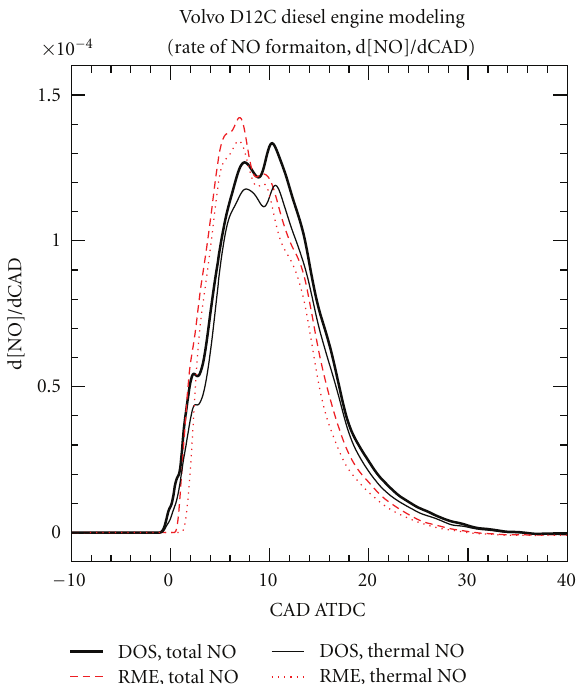
Figure 9: Averaged in-cylinder rates of NO formation for the Volvo D12C diesel engine fuelled by DOS (black solid line) and RME (red dashed line), without EGR.